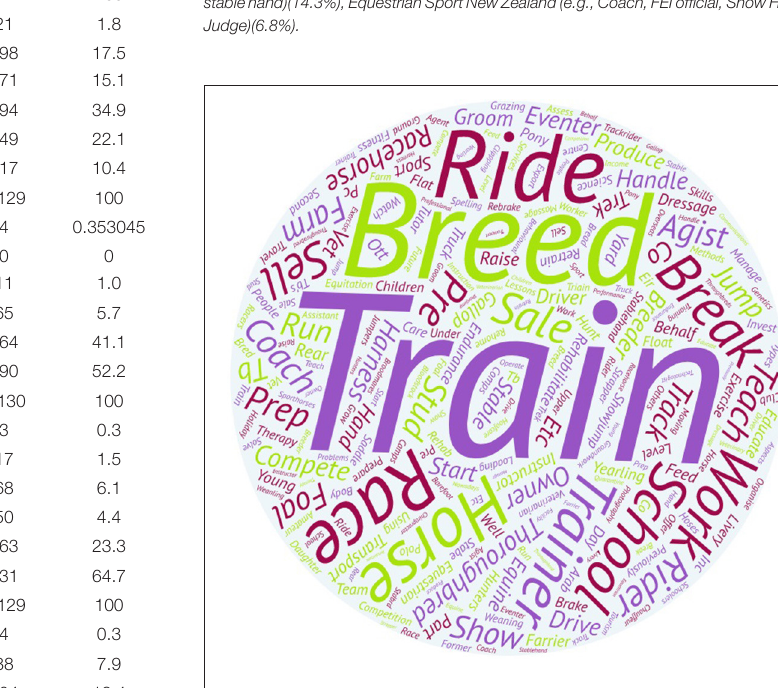
FIGURE 1 | Word art with the description of the professional activities carried out by the professional respondents. The size of a particular word represents a frequency of occurrence within the free text responses of the survey participants. In this case, respondents associated horse transport most frequently with the word “train,” followed by “breed “and “ride.” These words reflect the activities that those professionally engaged in the New Zealand equine industry are most likely to involved